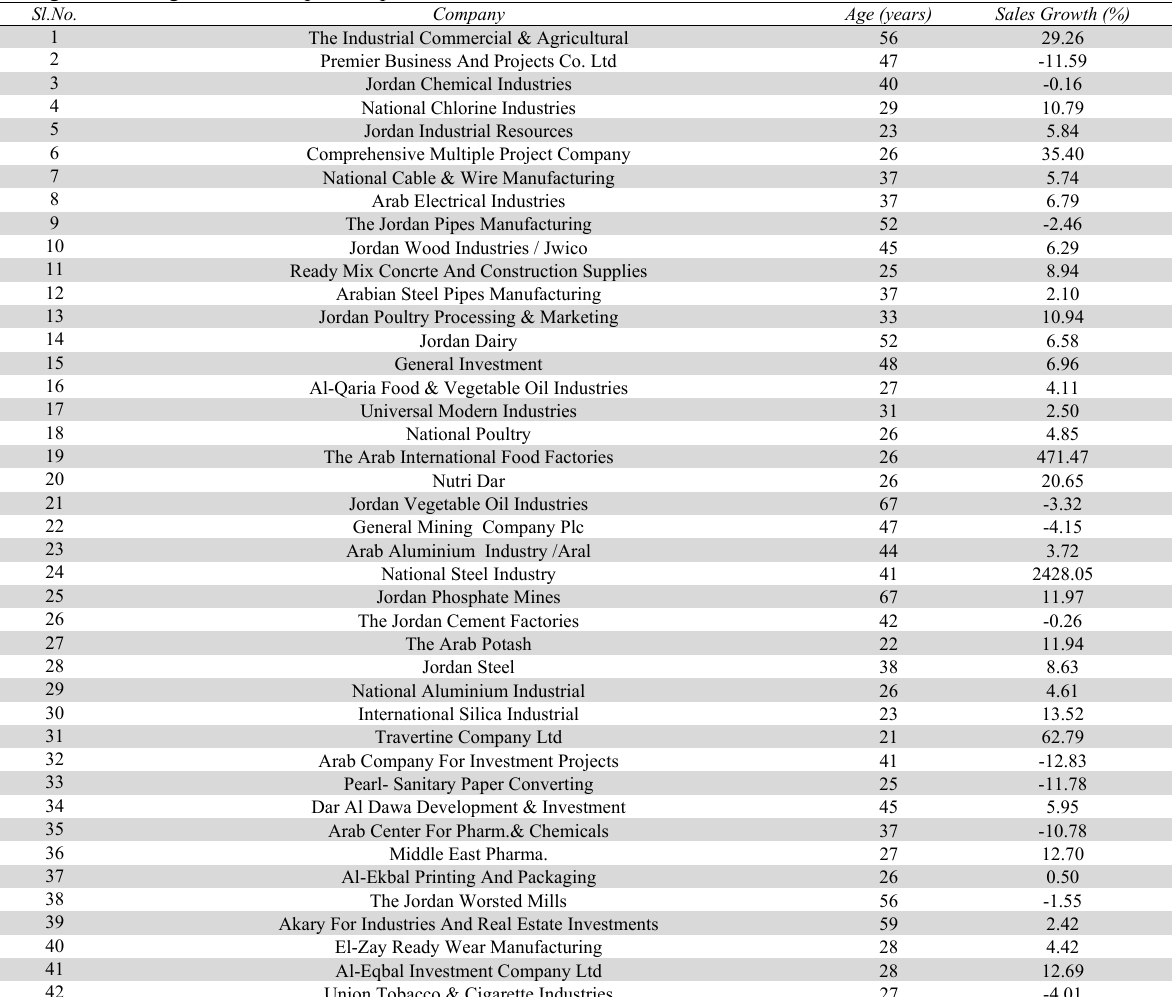
The age and sales growth of sample